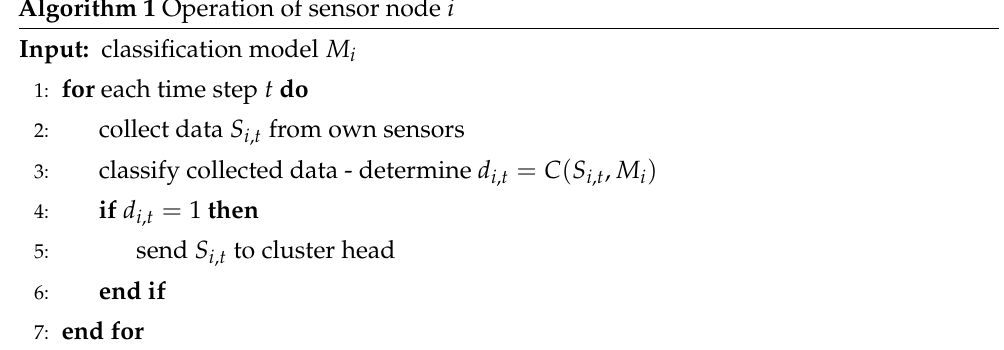
Algorithm 1 Operation of sensor node i